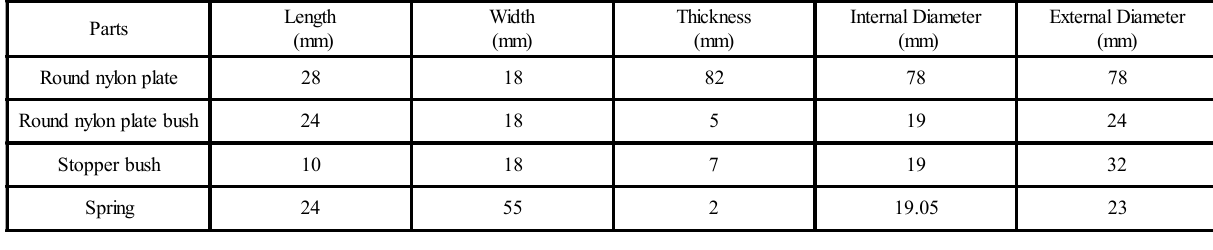
FIG.18 2D VIEWS OF SPRING